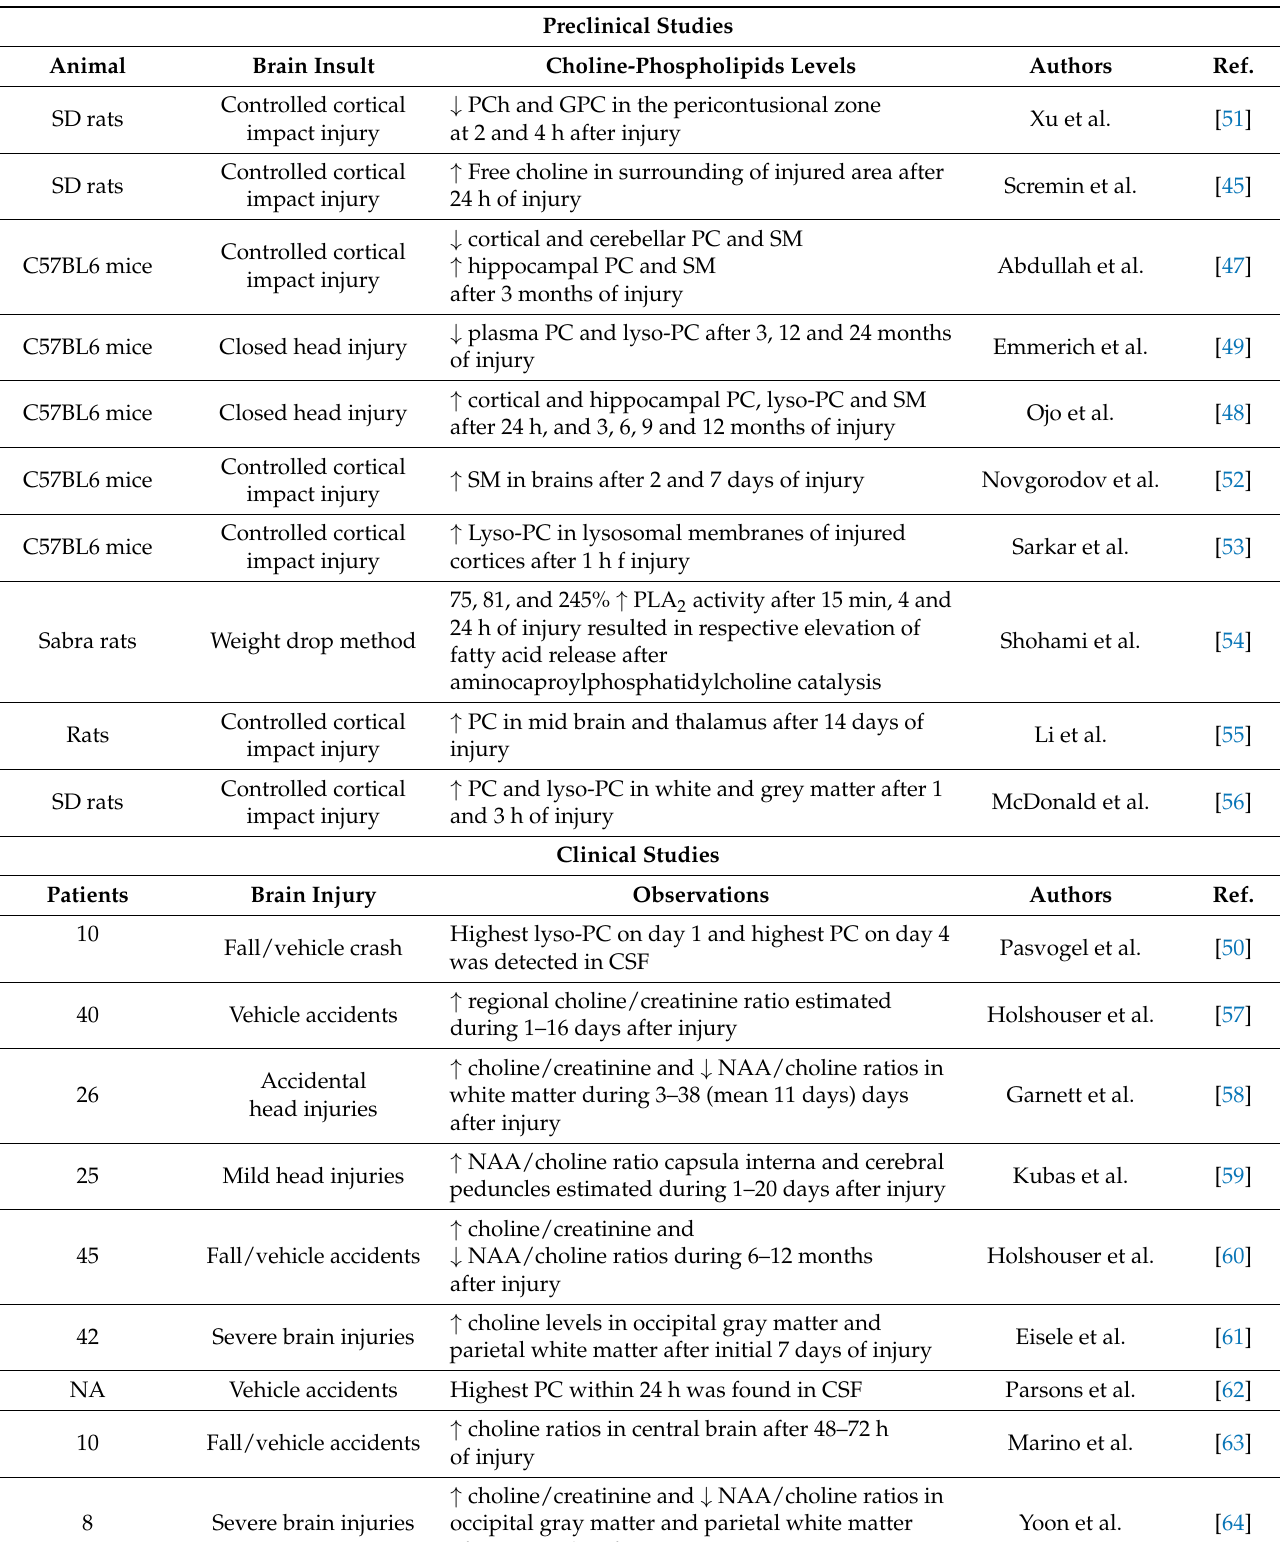
Table 3. Preclinical and clinical studies reporting the post-TBI changes in choline and choline-containing